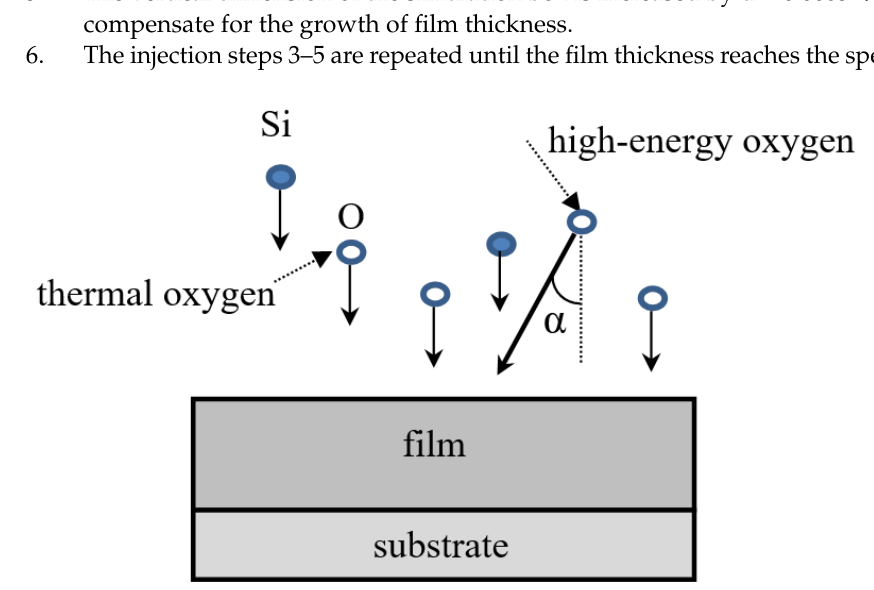
Figure 1. Scheme of the simulation of the ion-assisted deposition. The periodic boundary conditions with NVT (constant number of particles, volume, and temperature) ensemble are used in steps 3 and 4. The Berendsen thermostat [18] is applied to keep the simulation box temperature, T = 300 K, constant. The potential energy of interatomic interaction is calculated using the DESIL force field [14]: